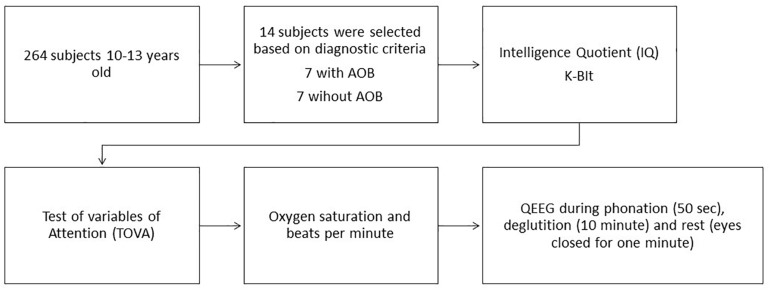
Measurement sequence and procedures.